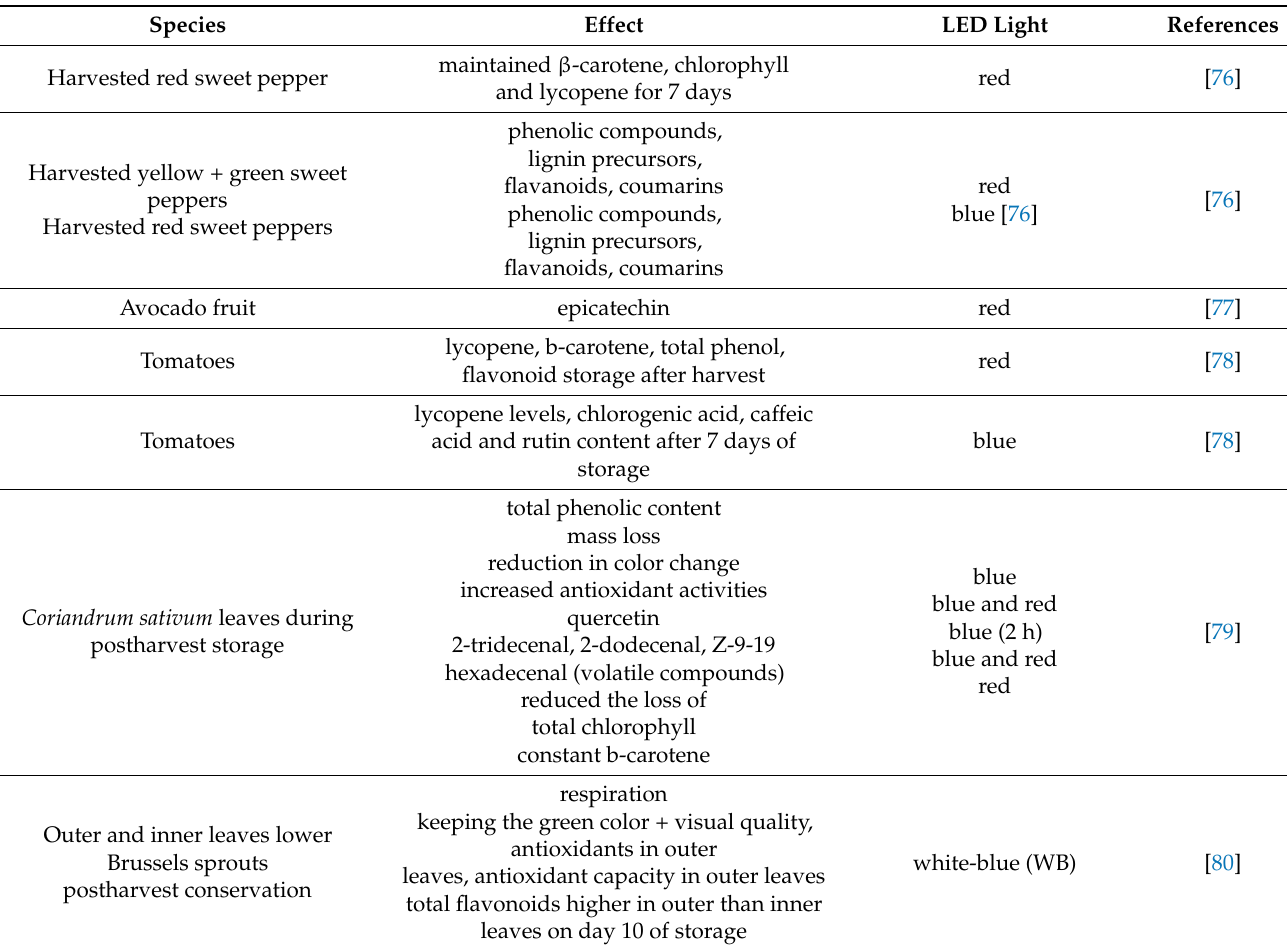
Table 3. The effect of LED on food preservation, postharvest